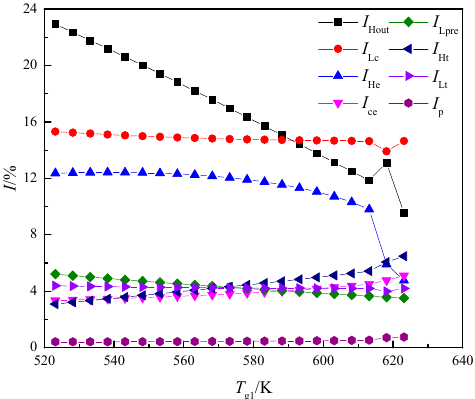
Figure 16. Effects of T g1 on exergy destruction rate for the benzene system.